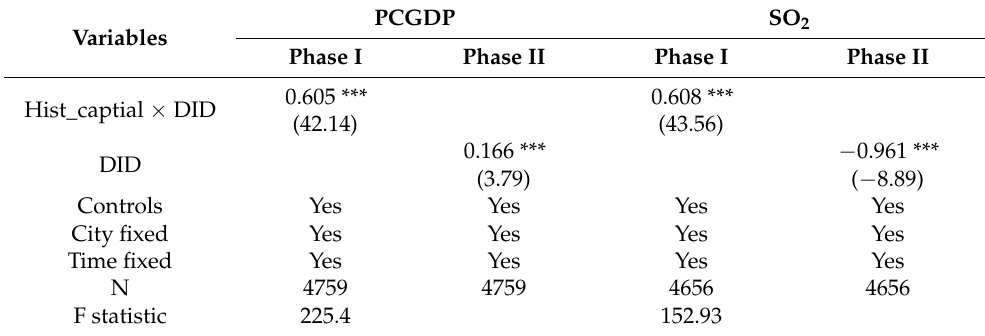
Table 5. Results of endogeneity test.